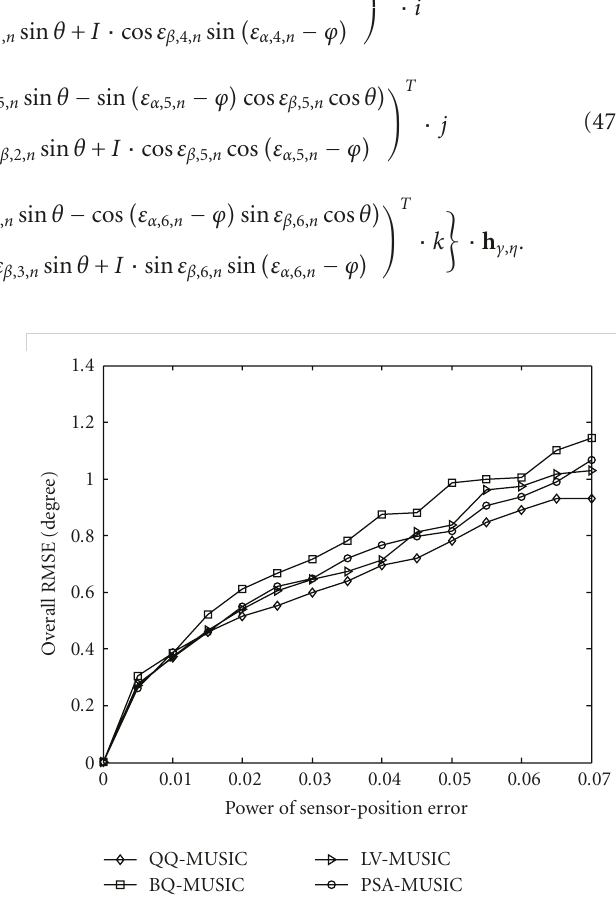
Figure 5: RMS estimation errors versus sensor position error